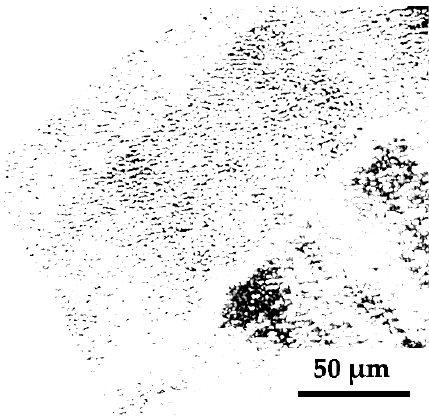
Figure 3. Image of the p-a-Si surface irradiated with N = 200, obtained by optical microscope in transmission mode. Dark sites are silicon isles surround surrounded by empty space, arisen because of complete film ablation.